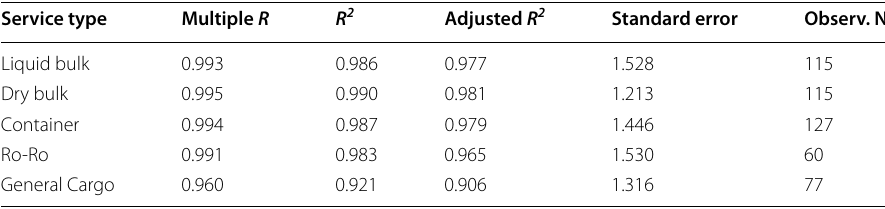
Table 6 Regression statistics